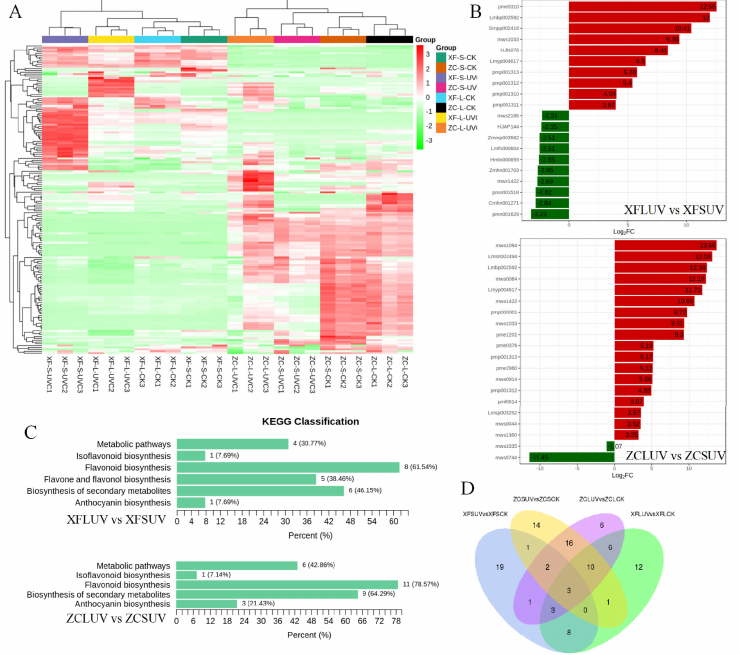
Figure 8. Characteristics of flavonoids accumulation in grape berries under UV-C treatment. ( A ) Clus- ter heat map of flavonoids in each sample. Red represents upregulation, while green represents downregulation. ( B ) Top fold change metabolites in the comparison group of XFLUV vs. XFSUV and ZCLUV vs. ZCSUV. Components in the top 20 Log 2 FC are listed, and their information is provided in Table S6. ( C ) KEGG enrichment of differential metabolites in the comparison group of XFLUV vs. XFSUV and ZCLUV vs. ZCSUV. The number next to each bar represents the number of enriched differential metabolites, and cluster_frequency in brackets represents the ratio of the number of differential metabolites to the total number of differential metabolites annotated in KEGG. ( D ) The intersection of differential flavonoids between different treatment